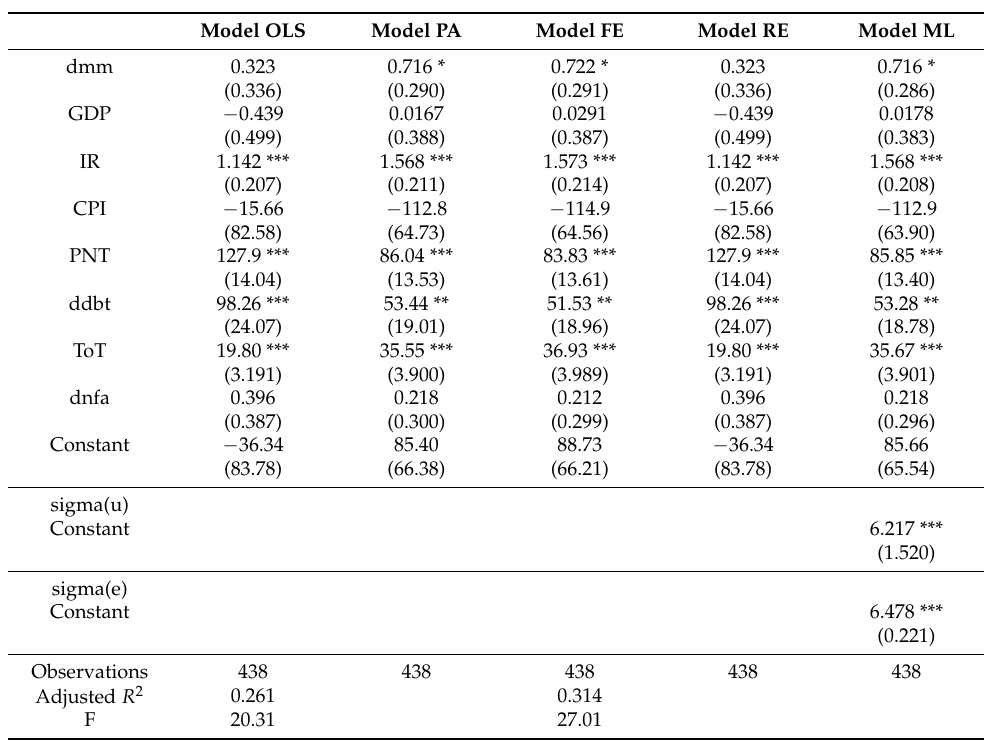
Table A12. Panel Regression Table AM Model 2.